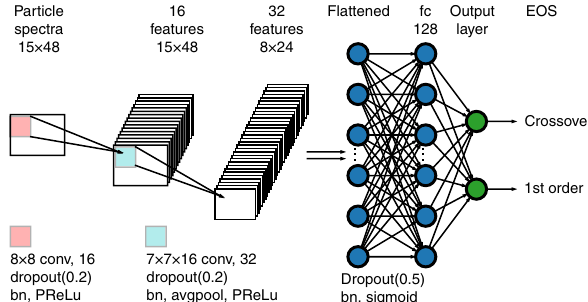
Fig. 3 The convolution neural network architecture. The architecture is designed to identify the quantum chromodynamics transition by using particle spectra with 15 transverse momentum p T bins and 48 azimuthal angle ϕ